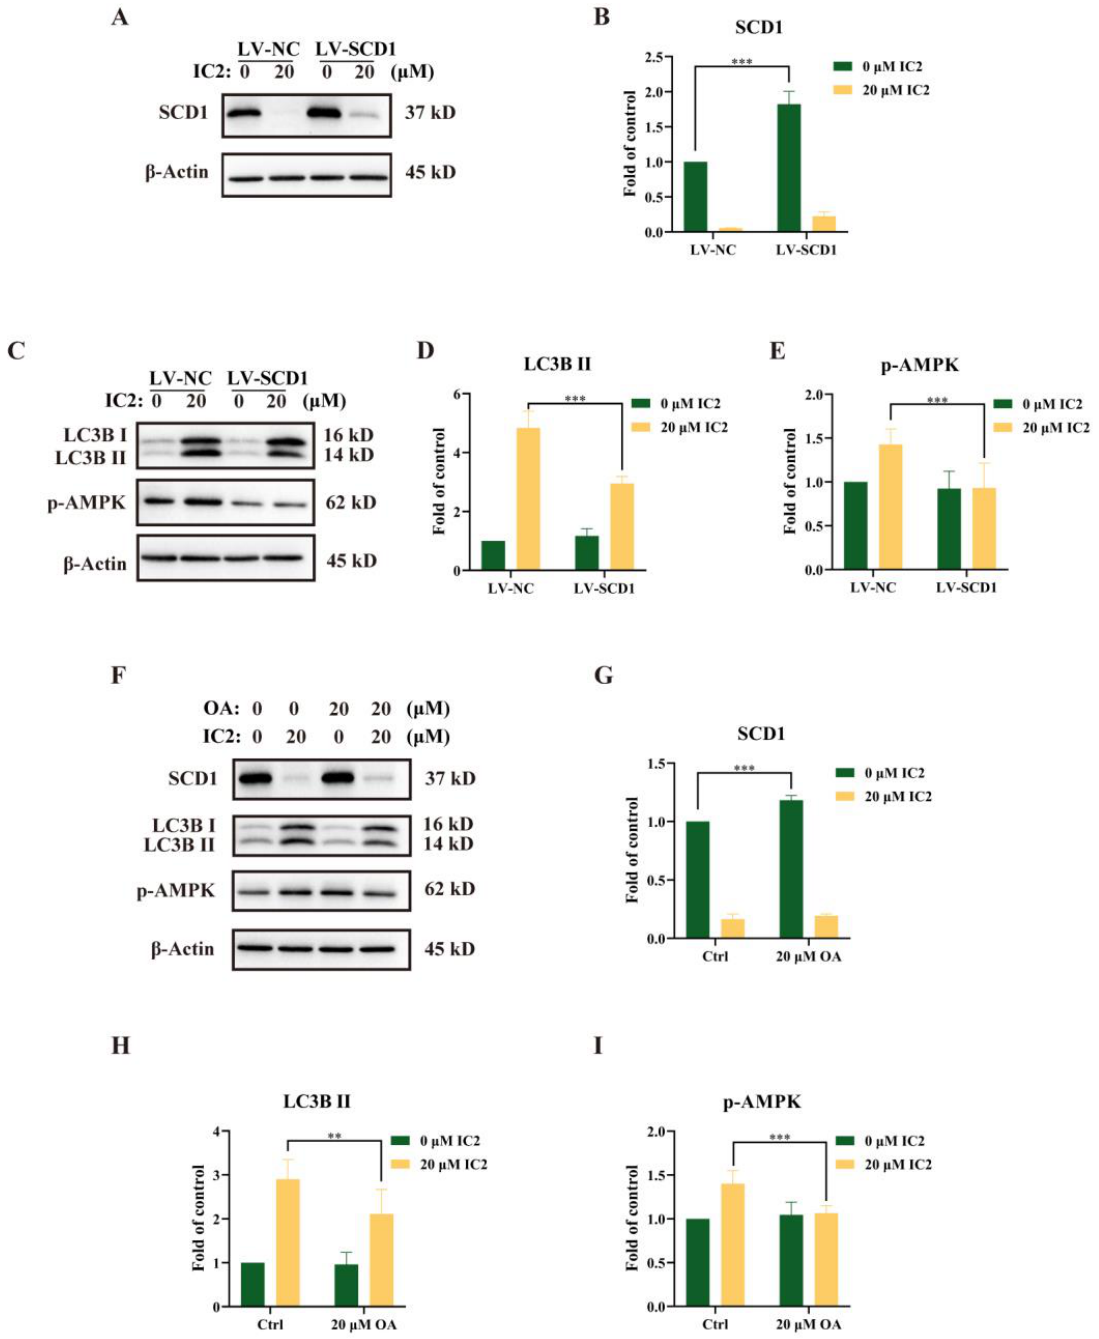
Figure 5. IC2-induced autophagy was alleviated by overexpression of SCD1 or exogenous addition of OA. ( A ) The expression of SCD1 was determined in corresponding normal MCF-7 cell line (LV-NC) and SCD1-overexpressing MCF-7 cell line (LV-SCD1) by Western blot. ( B ) Quantification of the protein expression level of SCD1 in LV-NC and LV-SCD1. ( C ) The expression of LC3B and p-AMPK (Thr172) was determined in LV-NC and LV-SCD1 by Western blot. Quantification of the protein expression levels of ( D ) LC3B II and ( E ) p-AMPK (Thr172) in LV-NC and LV-SCD1. ( F ) The cells were treated with IC2 for 24 h in the presence or absence of OA in MCF-7 cells. The expression of SCD1, LC3B and p-AMPK (Thr172) was determined by Western blot. Quantification of the protein expression levels of ( G ) SCD1, ( H ) LC3B II and ( I ) p-AMPK (Thr172) in MCF-7 cells. All blots are representative of at least three repeats. * p < 0.05, ** p < 0.01 and *** p < 0.001 compared with the control group.